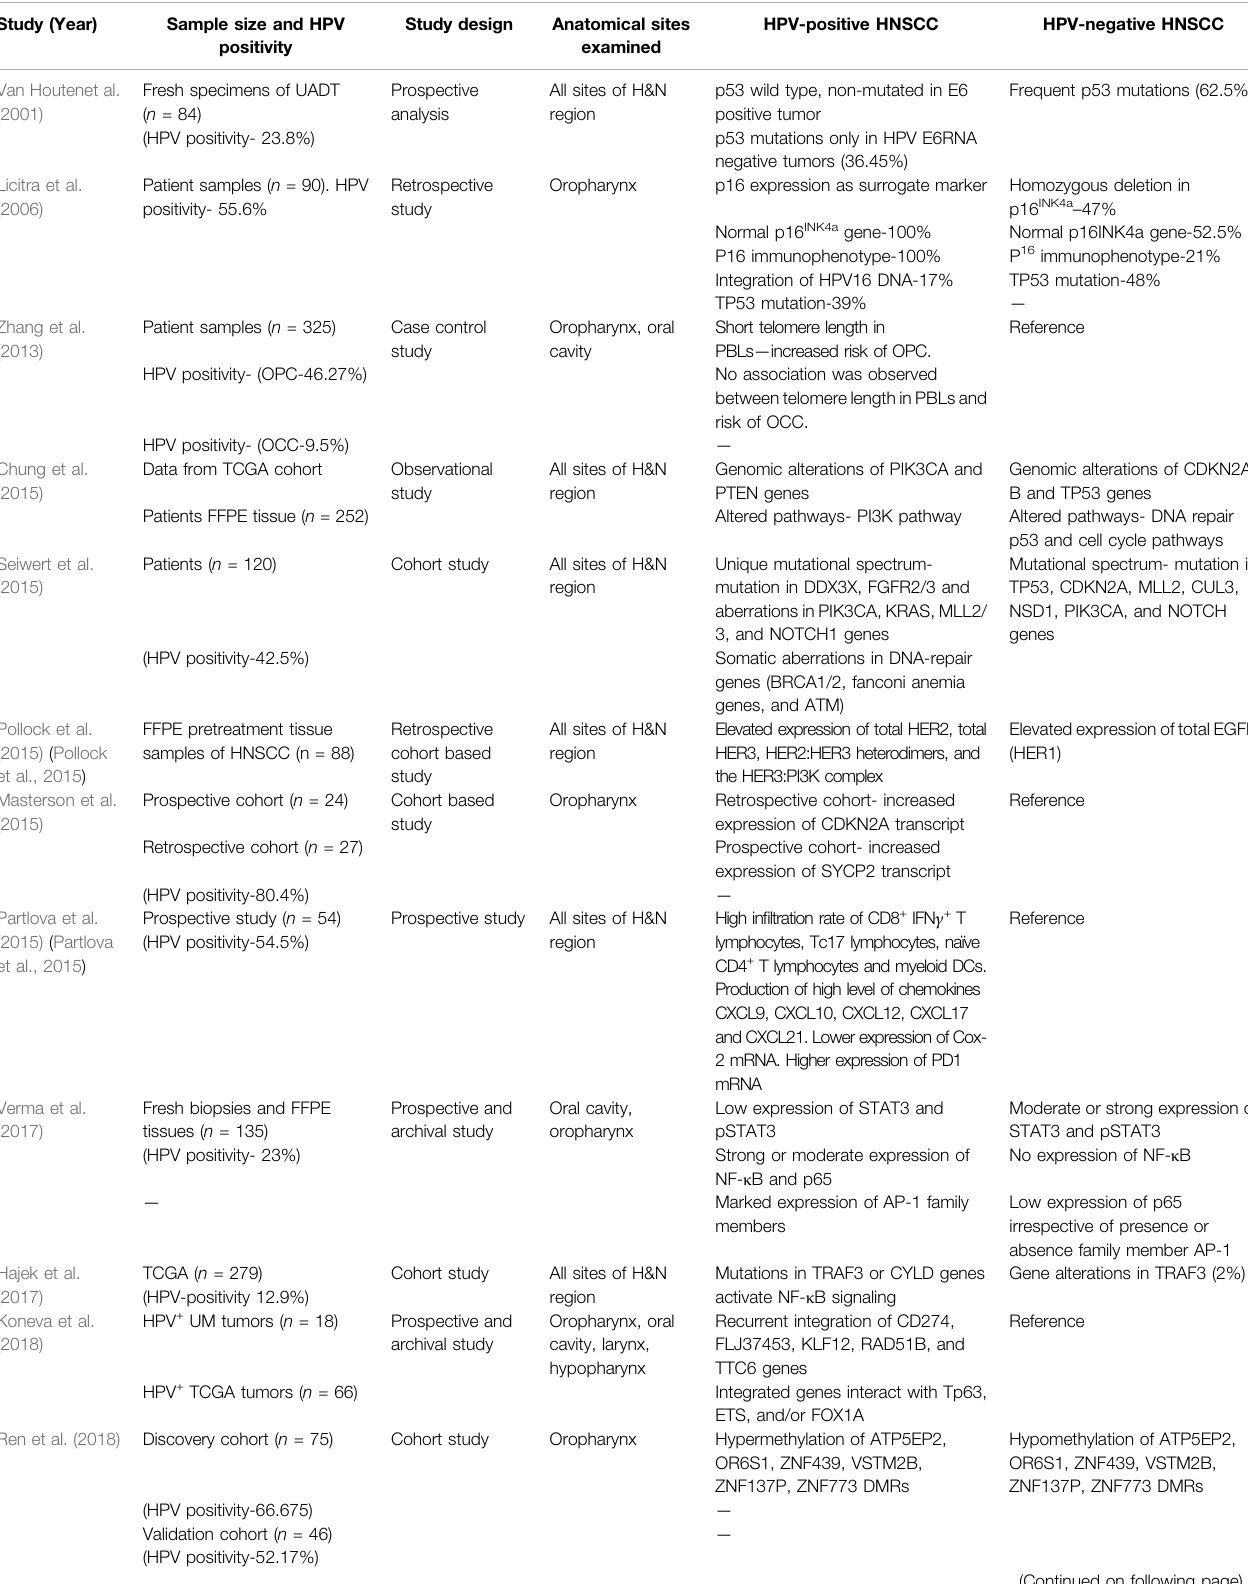
TABLE 3 | Representative studies showing speci fi c molecular differences in HPV negative vs HPV positive